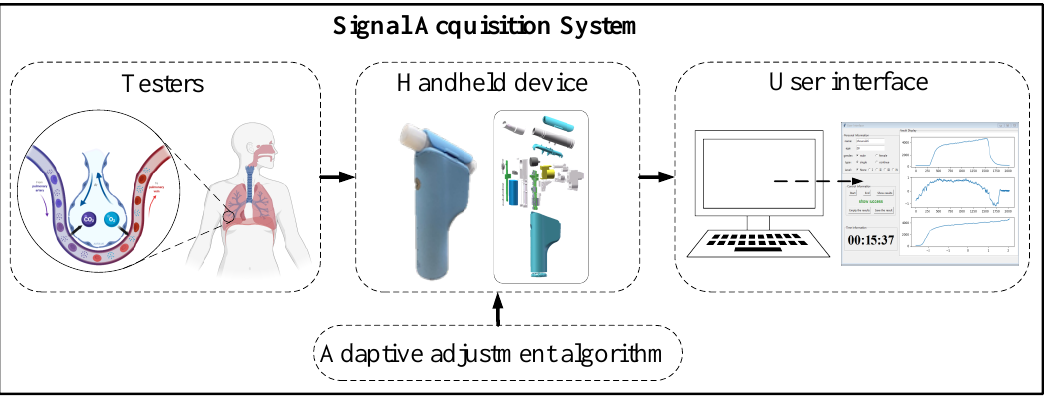
Figure 1. Signal acquisition system.